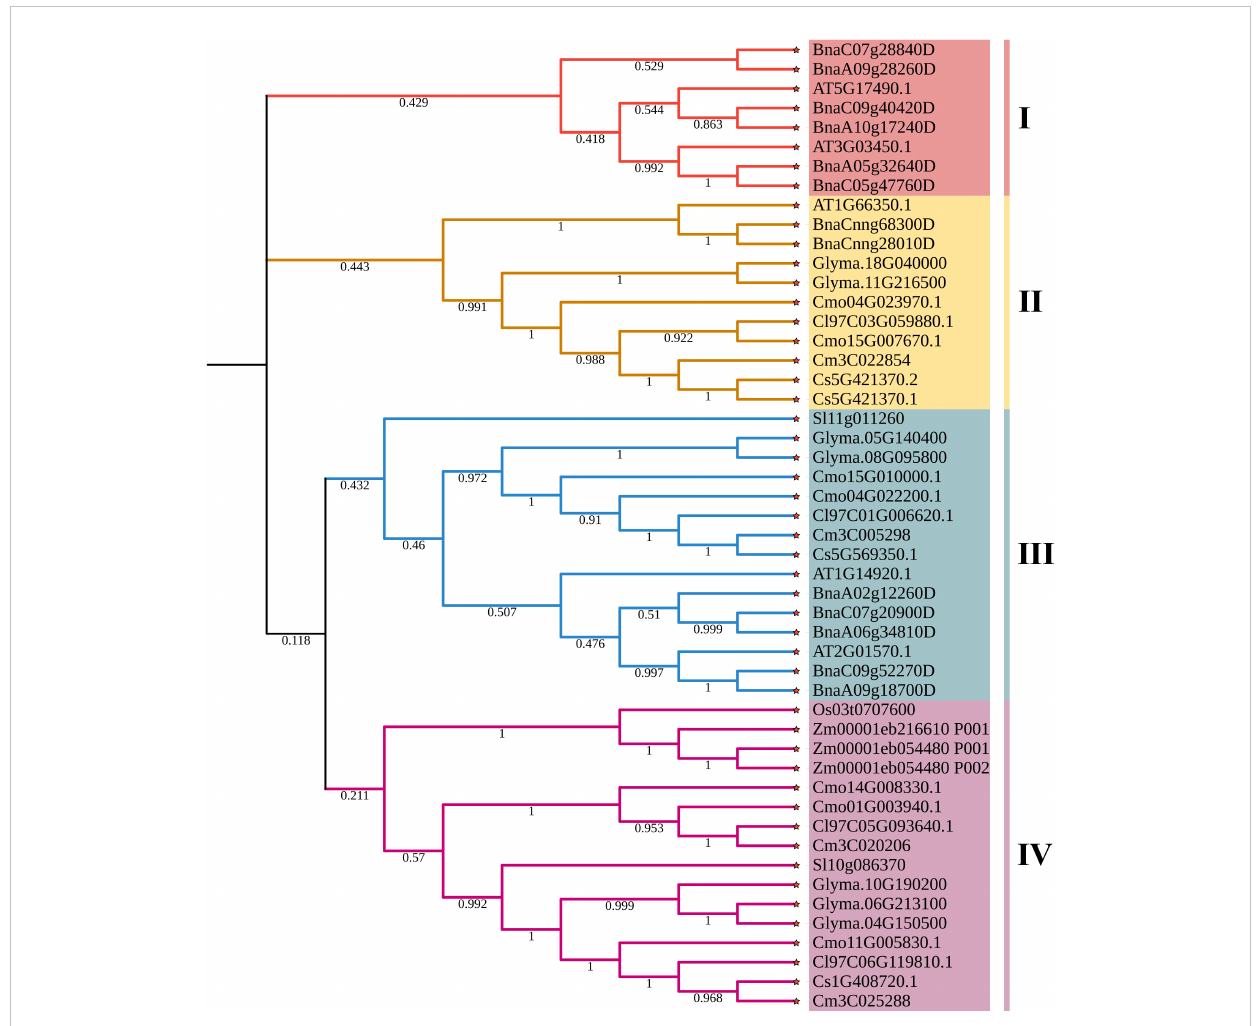
FIGURE 2 The phylogenetic tree of DELLA proteins from pumpkin, cucumber, melon, watermelon, Arabidopsis , soybean, Brassica napus , rice, tomato and maize. Cmo: pumpkin, Cs: cucumber, Cm: melon, Cl: watermelon, AT: Arabidopsis , Glyma.: soybean, Bna: Brassica napus , Os: rice, Sl: tomato, Zm: maize. The 4 major classes are represented by the different colors.